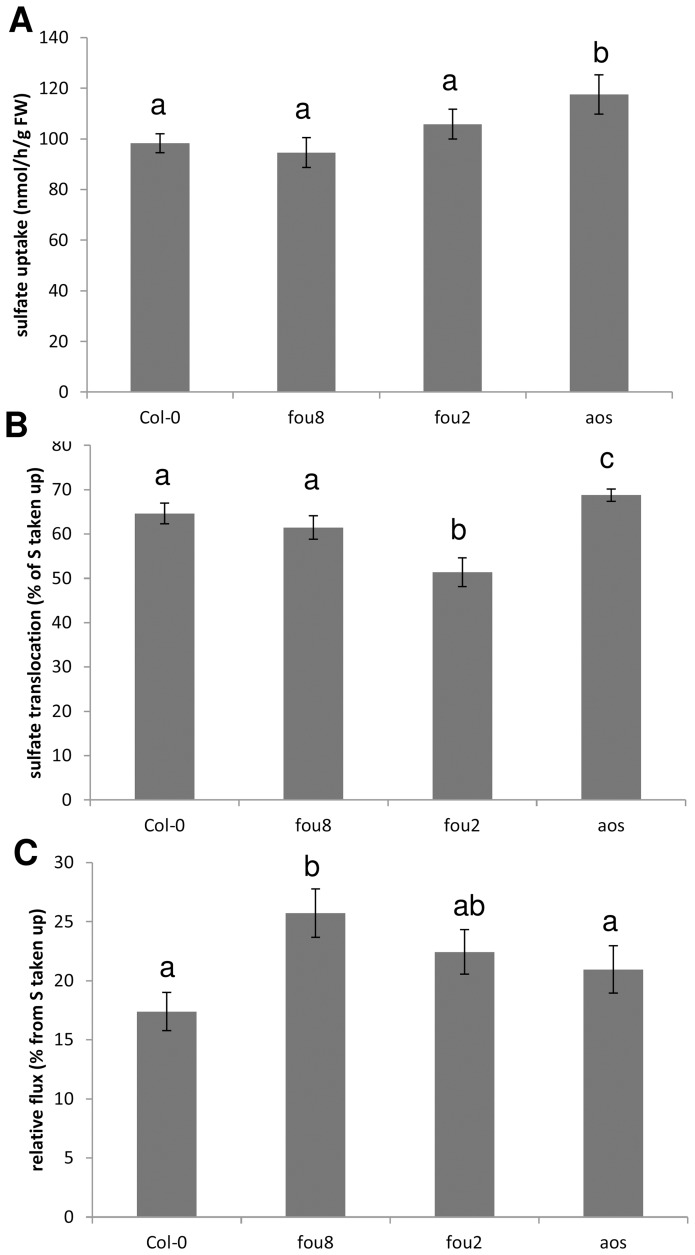
Sulfate uptake and flux through sulfate assimilation in fou8 and related mutants.WT Col-0 and mutants fou8, fou2, and aos were grown for 3 weeks on MS-phytagel vertical plates in controlled environment room. The seedlings were incubated for four hours with their roots submerged in nutrient solution adjusted to sulfate concentration of 0.2 mM and supplemented with 6.7 μCi [35S]sulfate. Shoot and root material was harvested separately, and the flux was determined as incorporation of 35S from [35S] sulfate to thiols and proteins. A sulfate uptake, B Percentage of 35S transported to leaves from the [35S]sulfate taken up, C relative flux through the sulfate assimilation in the leaves calculated as % of incorporation in thiols and proteins from total [35S]sulfate taken up. Results are presented as means ± SE from six independent pools of 8 seedlings grown in two independent experiments. Values marked with an asterisk show significant (P≤0.05) difference from Col-0.